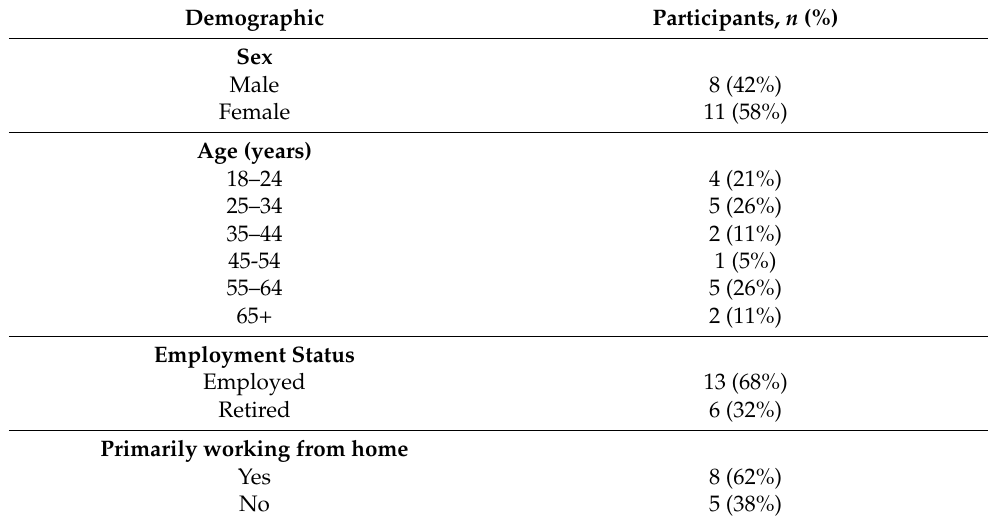
Table 1. Participant demographics ( n =